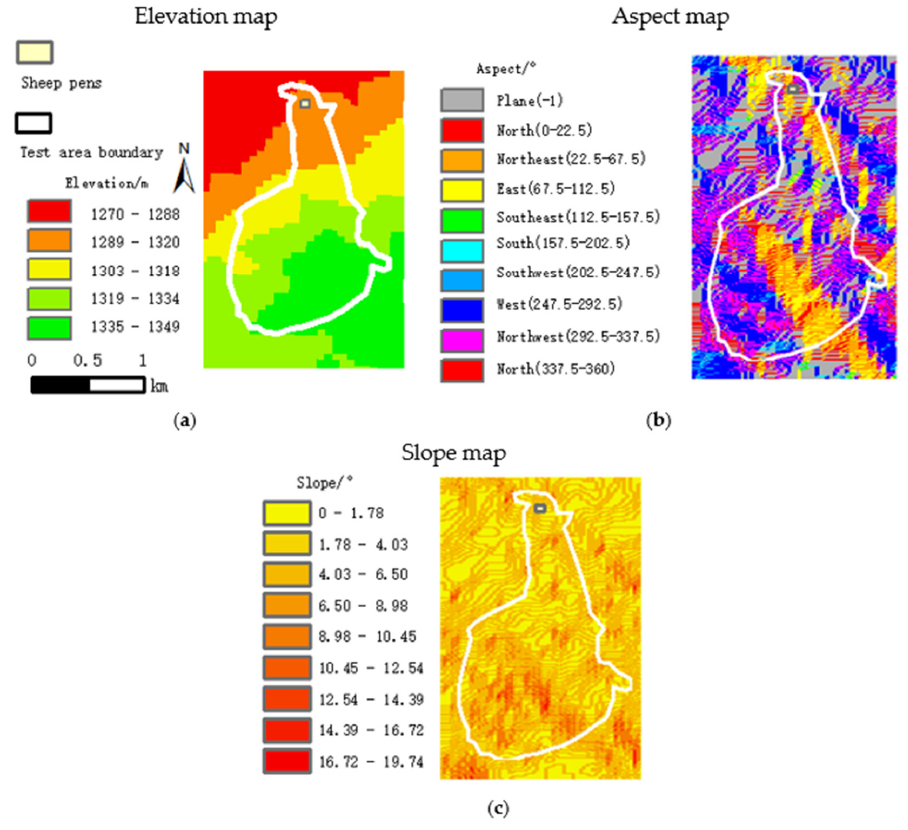
Figure 6. Topographic parameter maps of the test area. ( a ) Elevation map, ( b ) Aspect map, ( c ) Slope map.